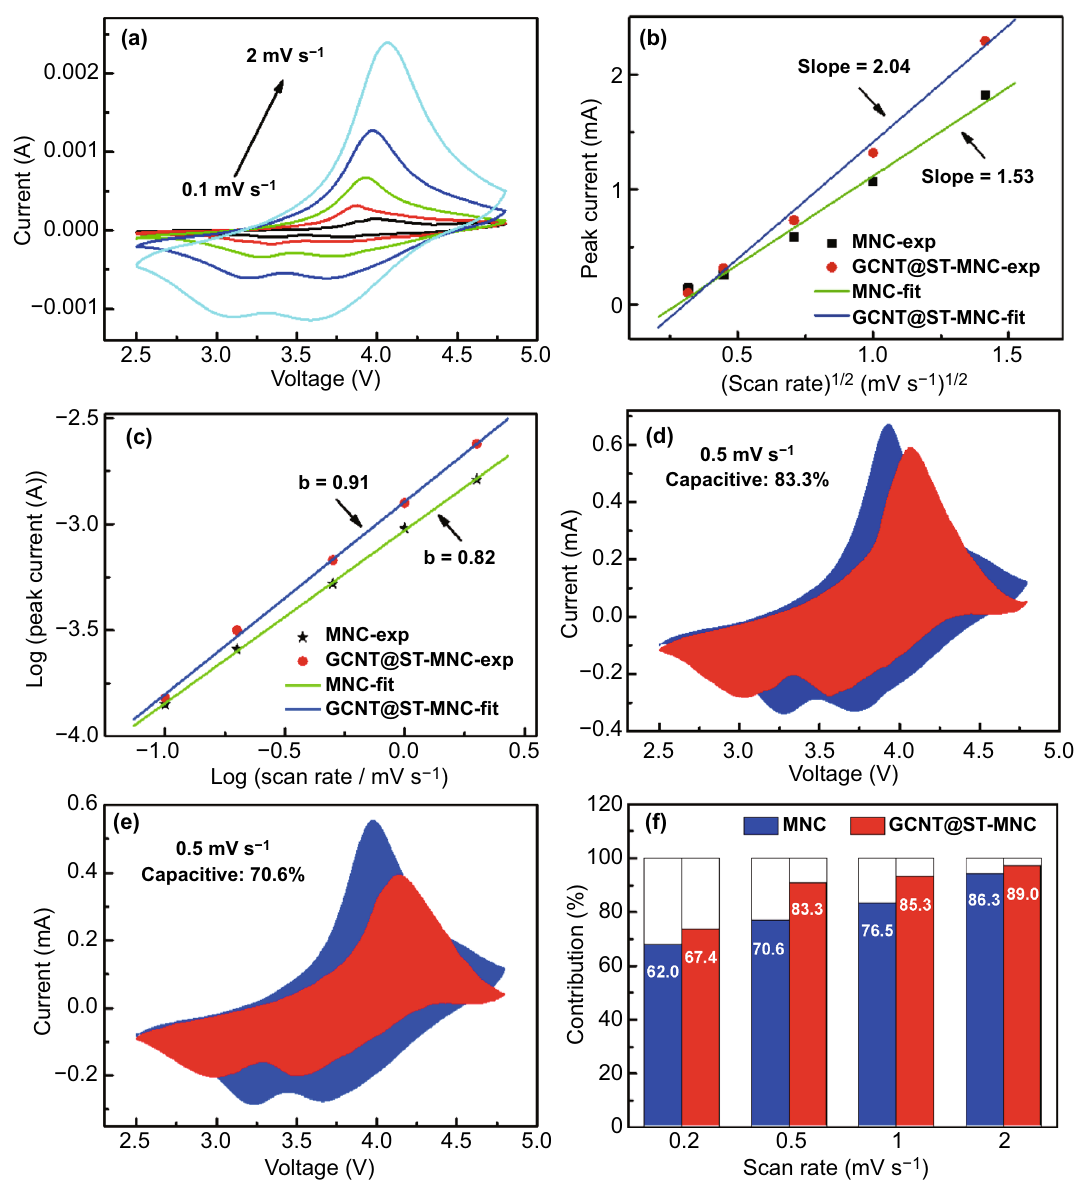
Fig. 5 a CV curves of GCNT@ST-MNC at various scan rates from 0.1 to 2 mV s −1 . b Plotting of peak current ( I p ) vs. square root of scan rate ( v 1/2 ). c Plotting of log(peak current, I p ) vs. log(scan rate, v ) ( b refers to the slope of fitting line). Total current (blue region area) and capacitive current (red region area) at 0.5 mV s −1 for d GCNT@ST-MNC and e MNC. f Comparison of capacitive contributions at various scan